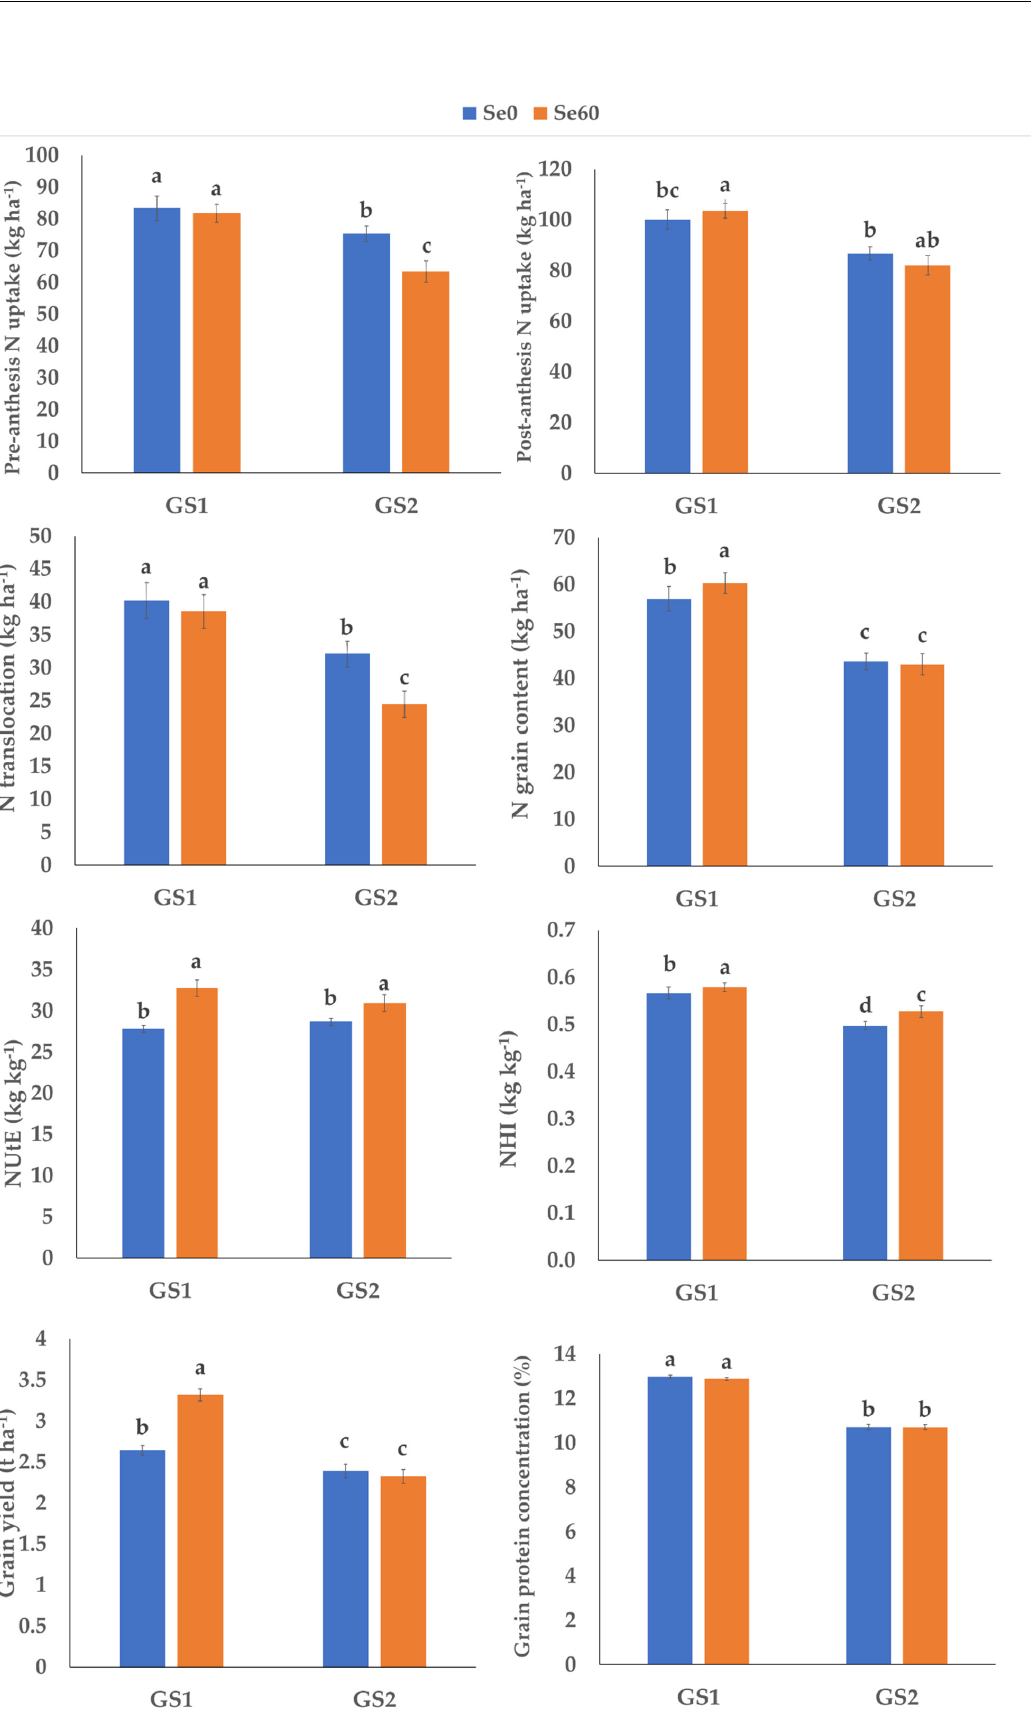
Figure 2. Effect of interaction growing season × selenium application on pre-anthesis N uptake (kg ha − 1 ), post-anthesis N uptake (kg ha − 1 ), N translocation (kg ha − 1 ), nitrogen utilization efficiency (NUtE; kg kg − 1 ), nitrogen harvest